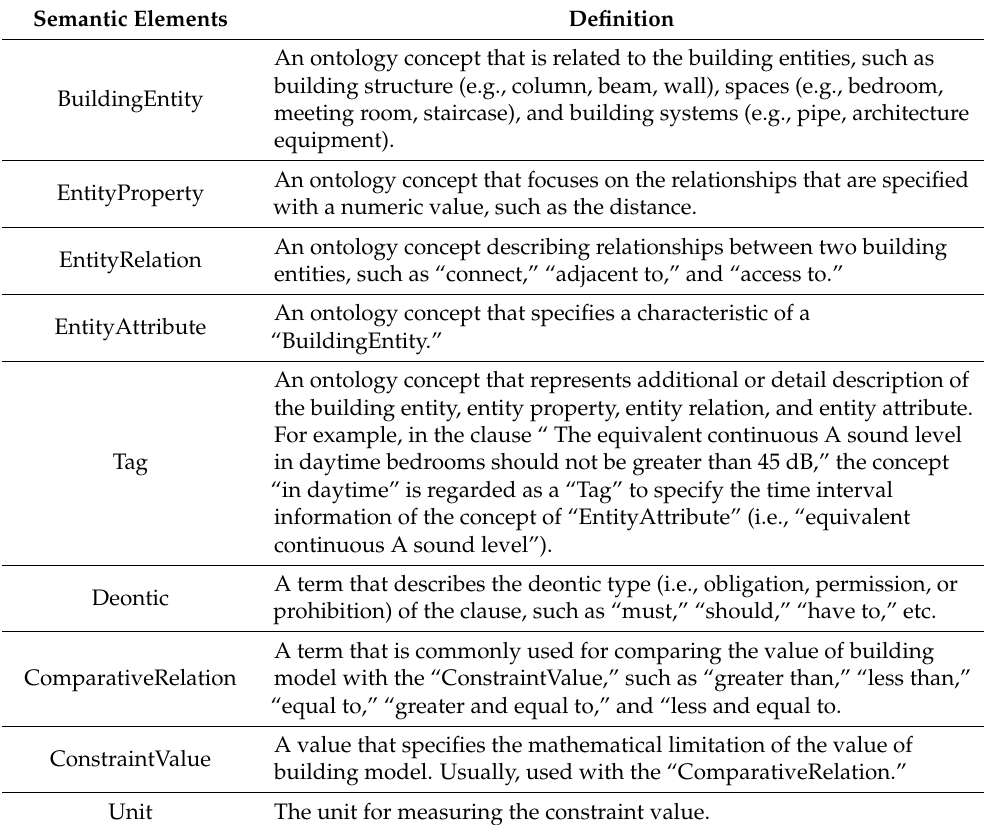
Table 2. Definitions of the proposed semantic elements for the terms in building